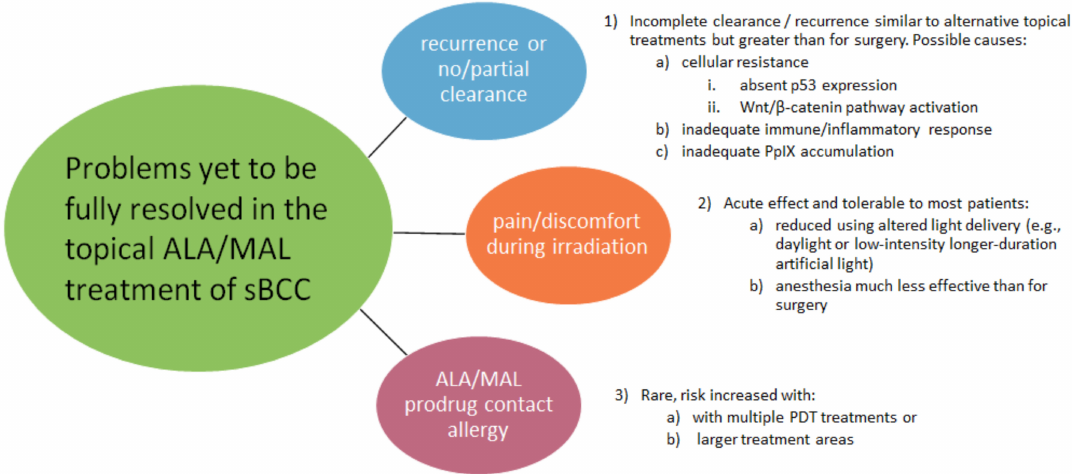
Figure 4. Schematic indicating the remaining problems in the topical photodynamic therapy (PDT) of superficial basal cell carcinoma (sBCC). (MAL, methyl aminolevulinate; ALA, aminolevulinic acid; and BCC, basal cell